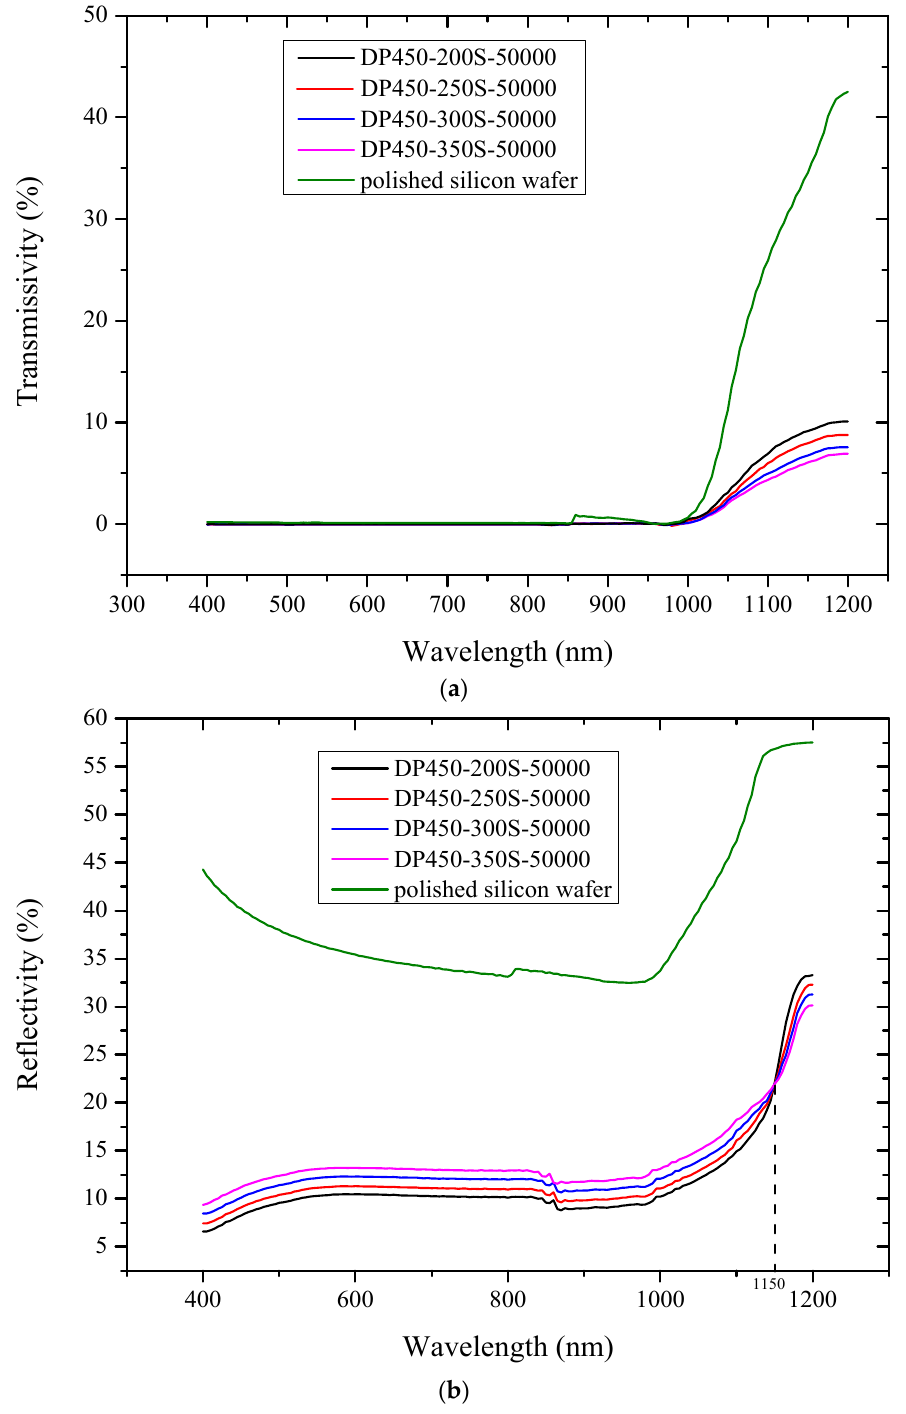
Figure 3. The comparison of optical characteristics for all samples fabricated from the different parameters of AAO: ( a ) the comparison of transmissivity for all samples at 400–1200 nm band; ( b ) the comparison of reflectivity for all samples at 400–1200 nm band.